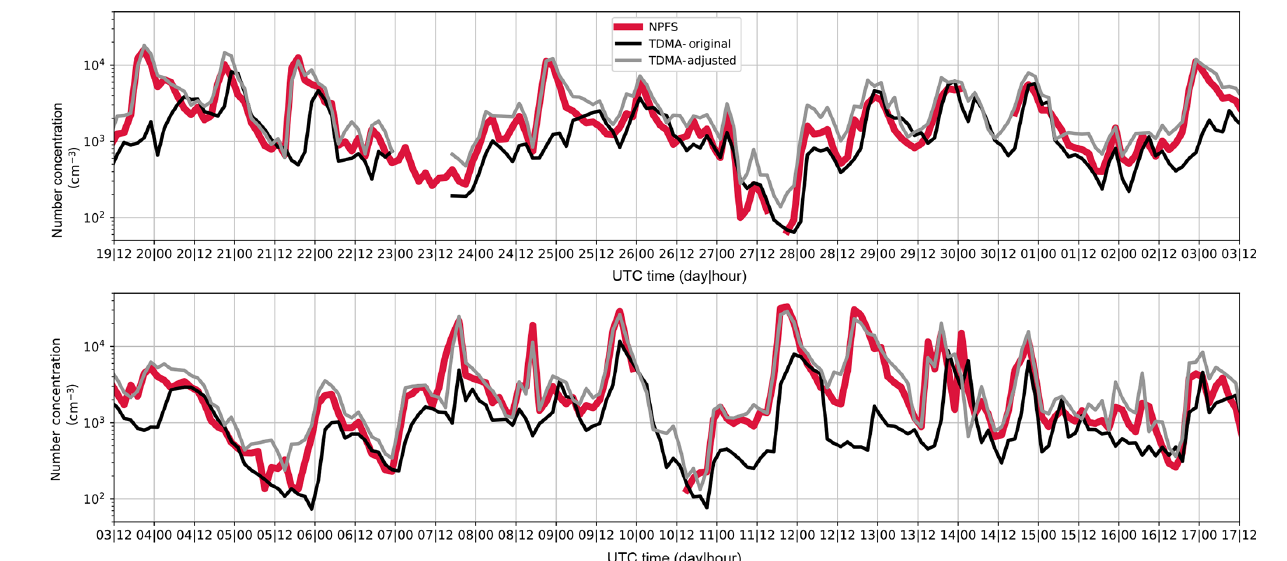
Figure A3. Time series of the integrated aerosol number concentrations between 7 and 30nm in the New Particle Formation Study (red) and the SMPS + APS size distributions both before the adjustments (original, black) and after the adjustments (adjusted, gray). The dates included were 19 April 2013 through 17 May